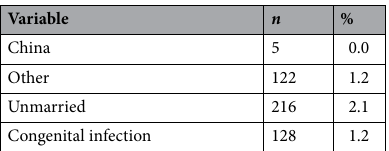
Table 1. Descriptive statistics: adverse birth outcomes and categorical predictors. DM, diabetes mellitus; PROM, prelabor rupture of membrane.